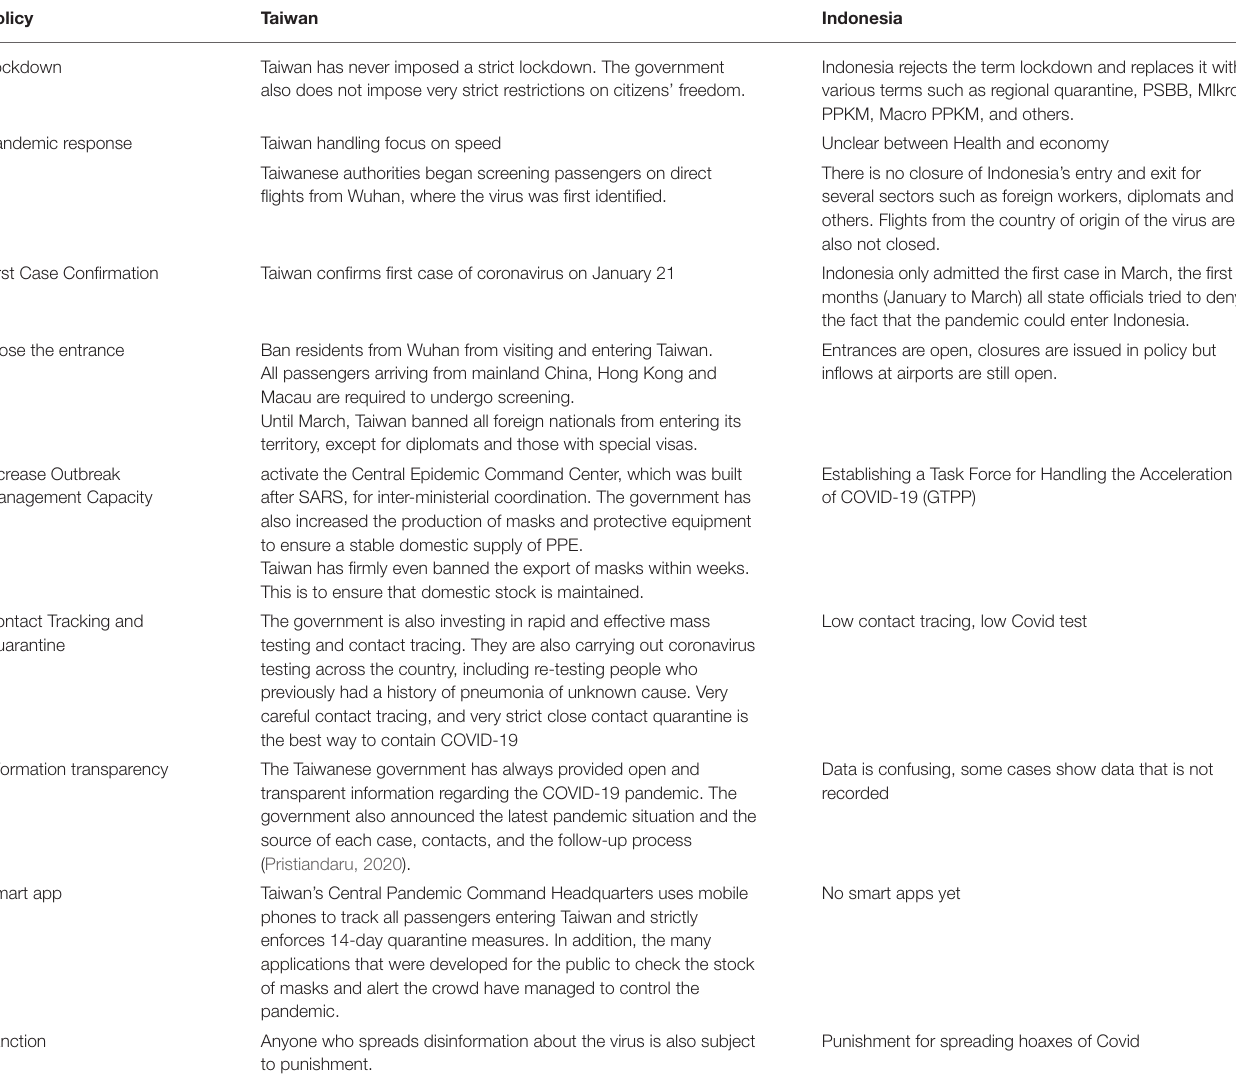
TABLE 1 | Differences in handling the COVID-19 pandemic in Taiwan and Indonesia. Policy Taiwan